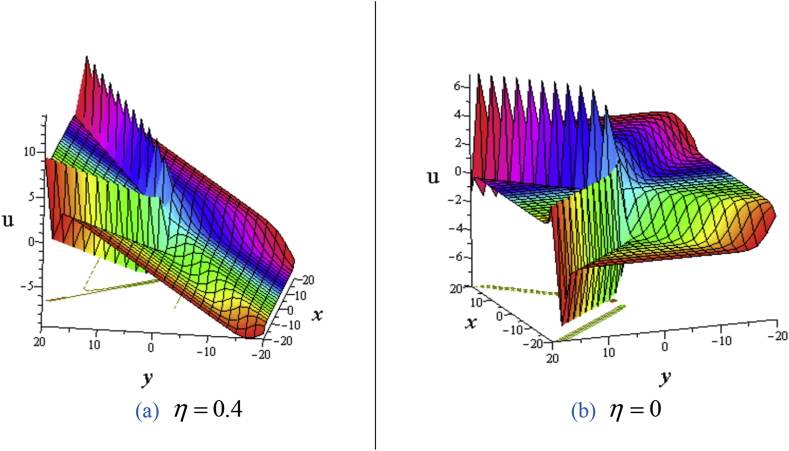
Profile of the Eq. (15) for ℓi=℘2=σ1=σ2=0,ℓ2=w1=σ=δ=σ4=1,η=0.4: 3D plot (upper) and contour plot (below) at t=0 where images (a) for η=0.4and (b) for η=0.